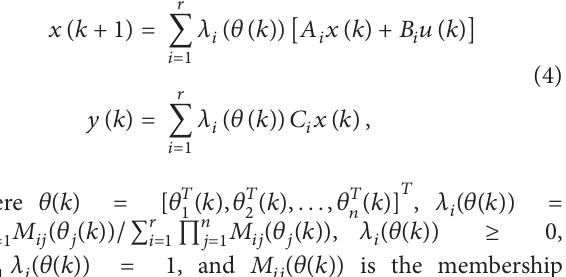
Figure 1: The structure of wireless networked control system. the controller, and the actuator reside in physically differ- ent nodes communicating over shared communication net- works. Due to the limited network bandwidth, unavoidable network congestion as well as network interruption, network transmission delay, and packet dropout during information exchange between different components appear.